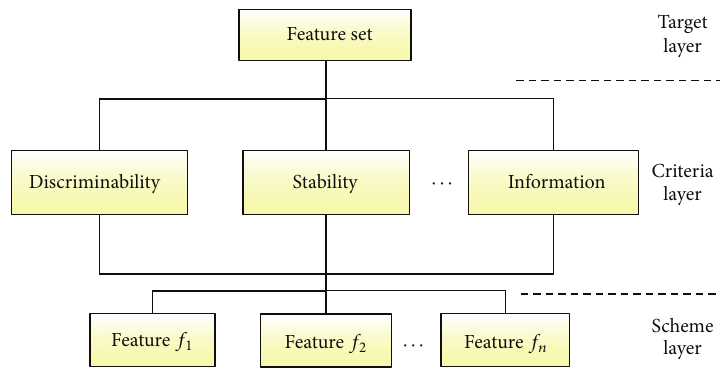
Figure 2: Hierarchy model for feature